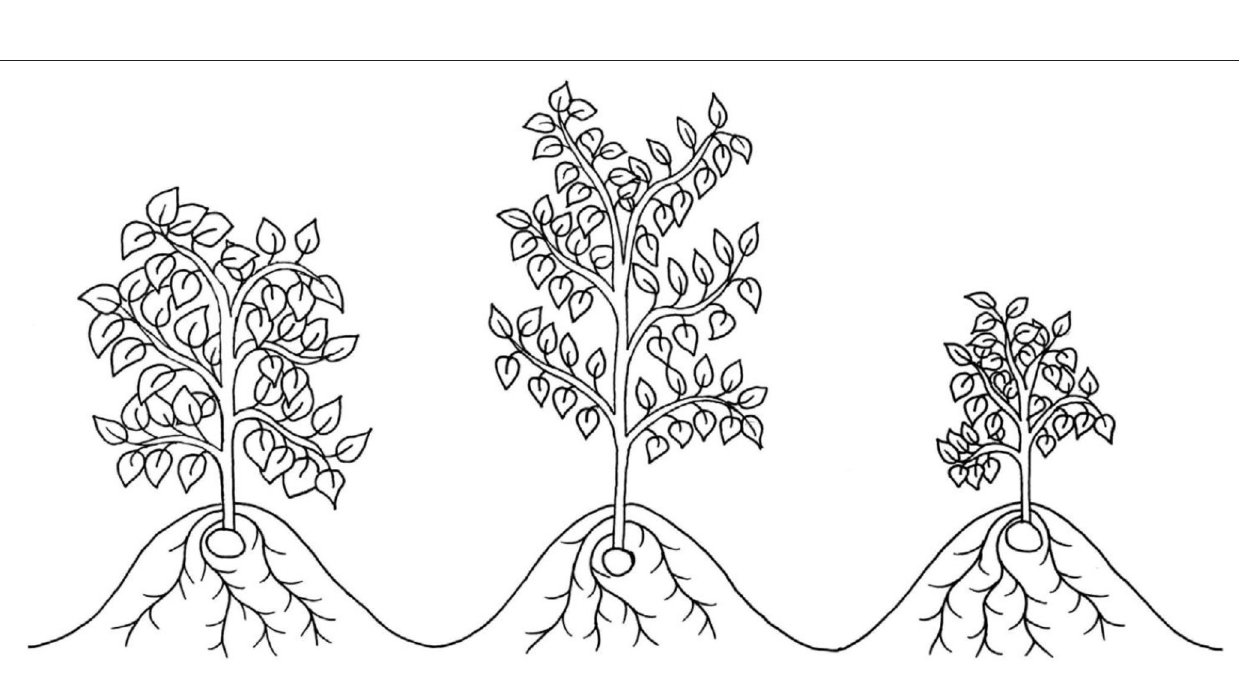
Frontiers in Plant Science | www.frontiersin.org